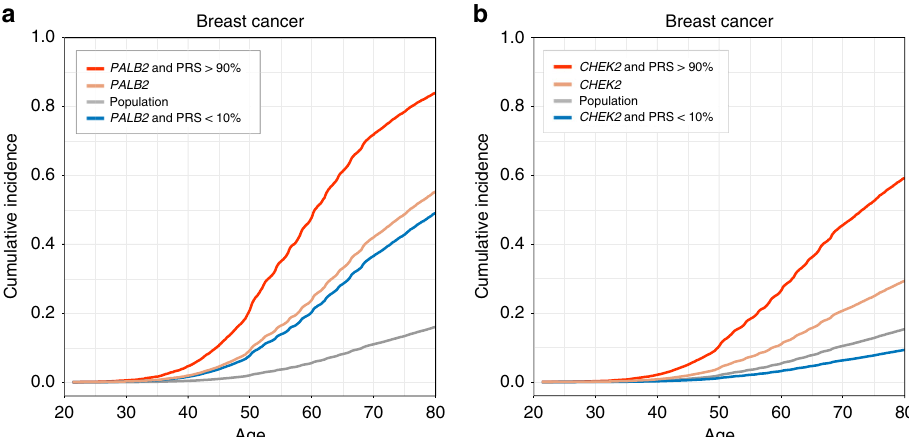
Fig. 2 The impact of polygenic risk in PALB2 and CHEK2 mutation carriers. Adjusted survival curves showing how the polygenic risk score (PRS) affects the breast cancer risk conferred by the PALB2 (panel A) and CHEK2 (panel B) frameshift mutations. Population level was de fi ned as women with PRS between the 10th and 90th percentiles. The PALB2 analysis was done in 109,371 women and CHEK2 analysis in 122,978 women. Adjusted survival curves Cox proportional hazards model. Table 3 Impact of polygenic risk score (PRS) on the breast cancer risk conferred by the PALB2 frameshift mutation. HR (95% CI) p value